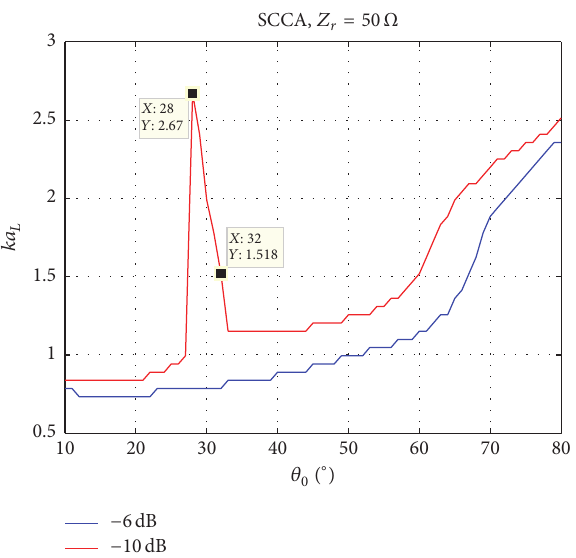
Figure 5: 𝑘𝑎 𝐿 × 𝜃 0 for the theoretical SCCA